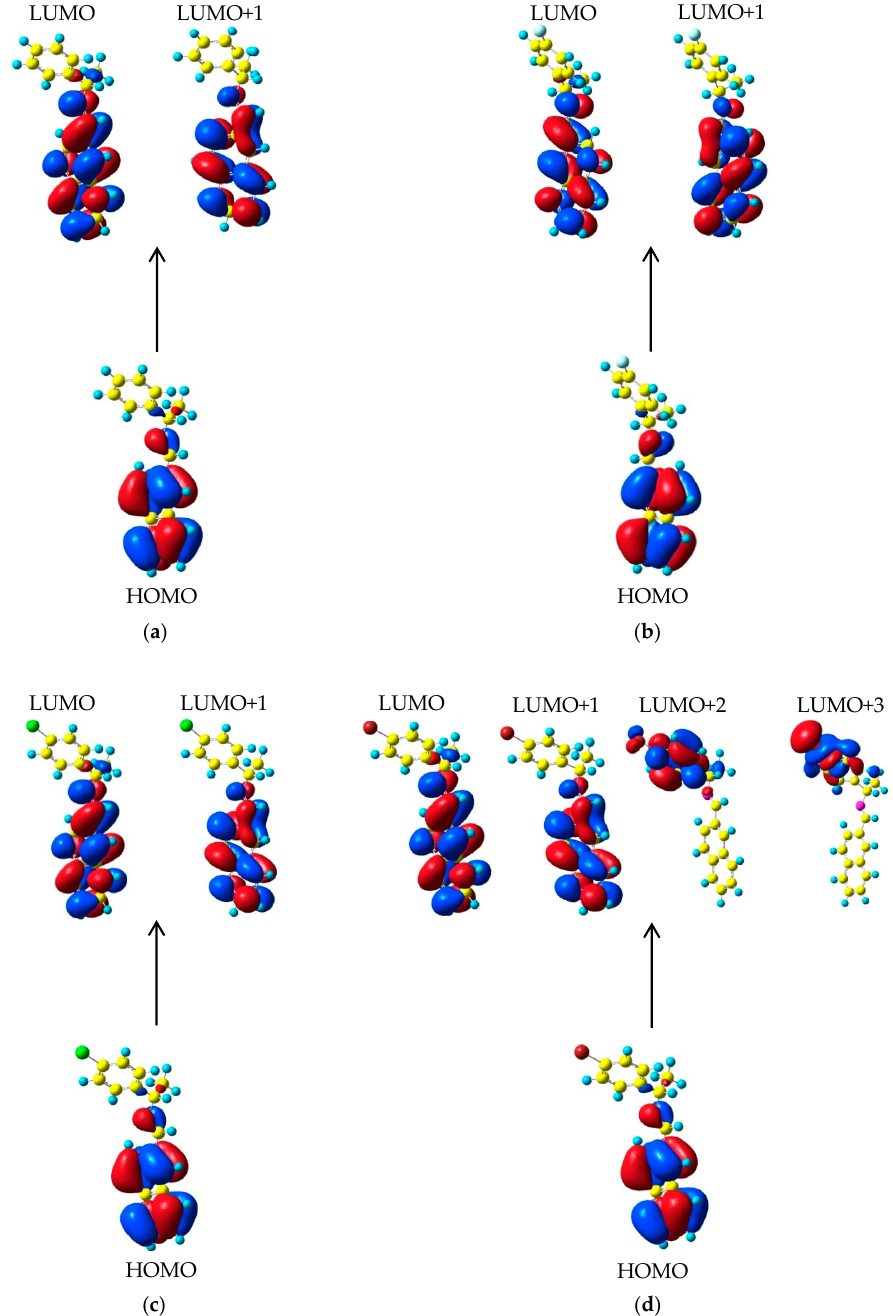
Figure 9. Isosurfaces of the frontier molecular orbitals with isovalue of 0.022 a.u. of ( a ) I , ( b ) I − F , ( c ) I − Cl , and ( d ) I − Br compounds.